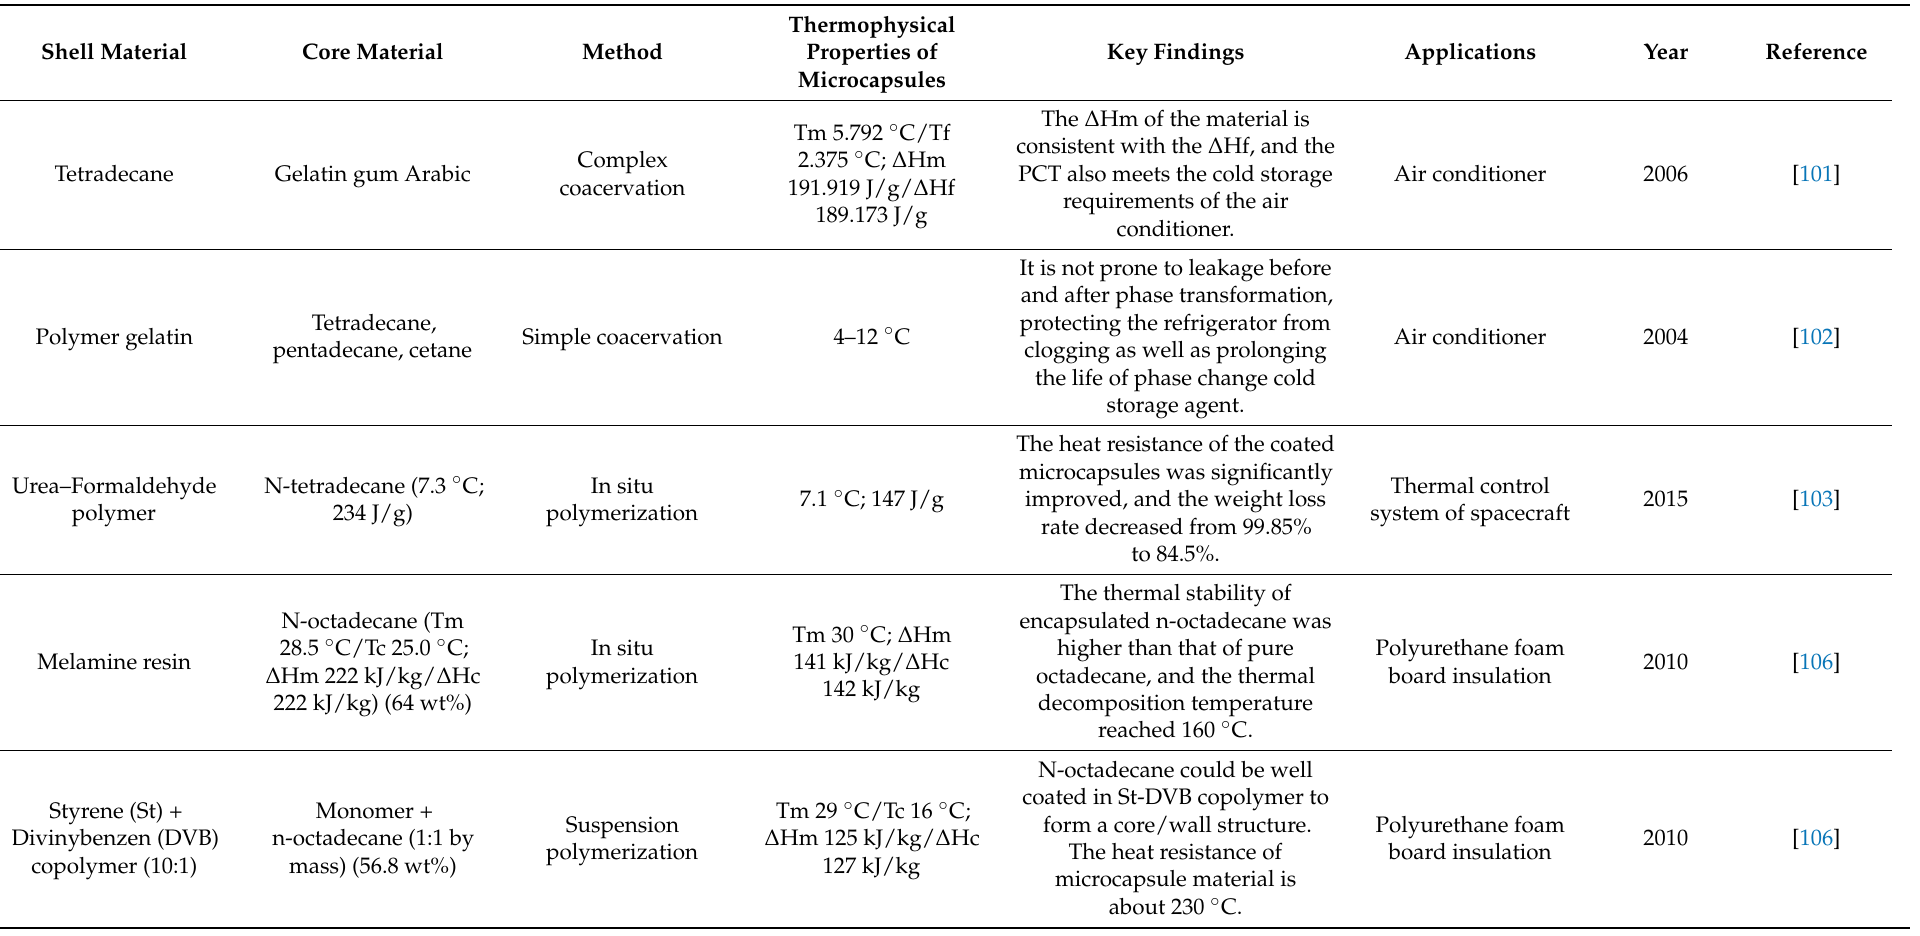
Table 7. Typical case of microencapsulation to enhance PCM